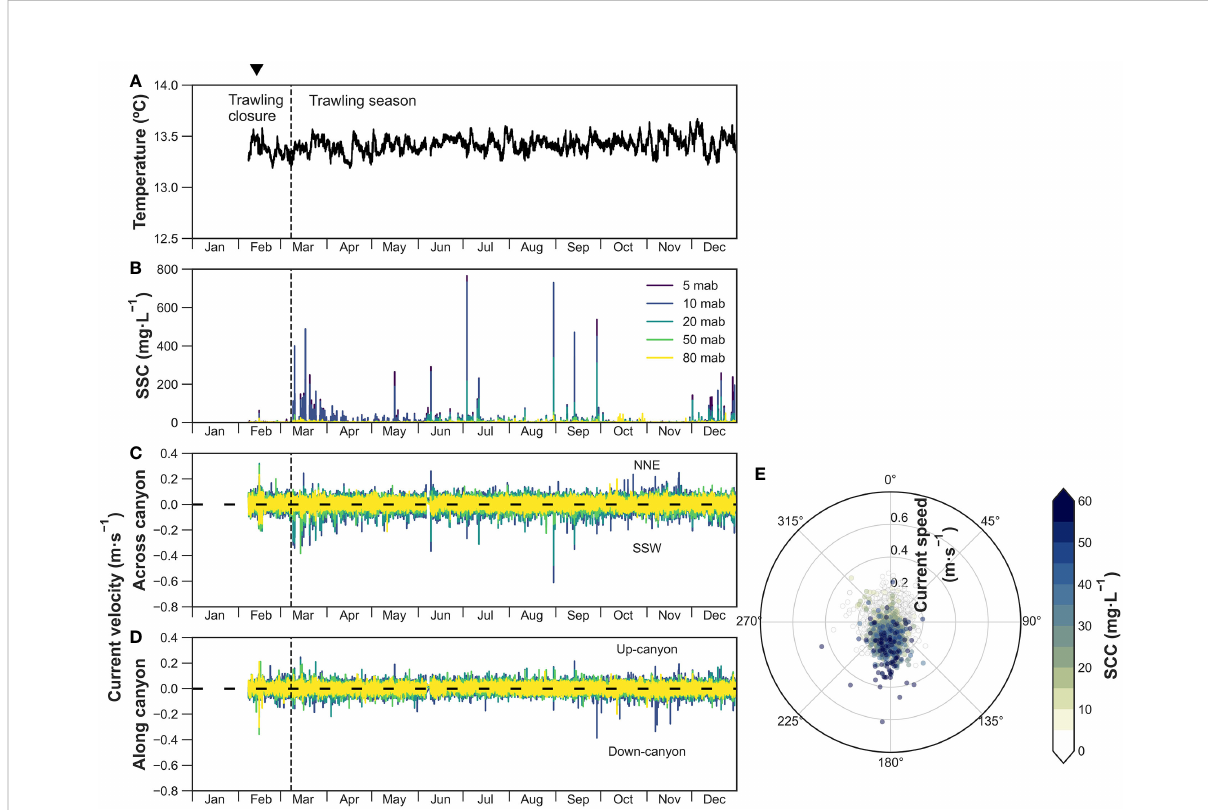
FIGURE 4 Flank-1000 time-series of (A) temperature at 5 mab, (B) suspended sediment concentration (SSC) at different water depths, (C) across-canyon current velocity at 10-80 mab, and (D) along-canyon current velocity at 10-80 mab. (E) Polar plot of non-rotated current direction (angle), current speed (radius) and turbidity (color bar) at 10 mab. The inverted triangle on top indicates the occurrence of a dense shelf water cascading